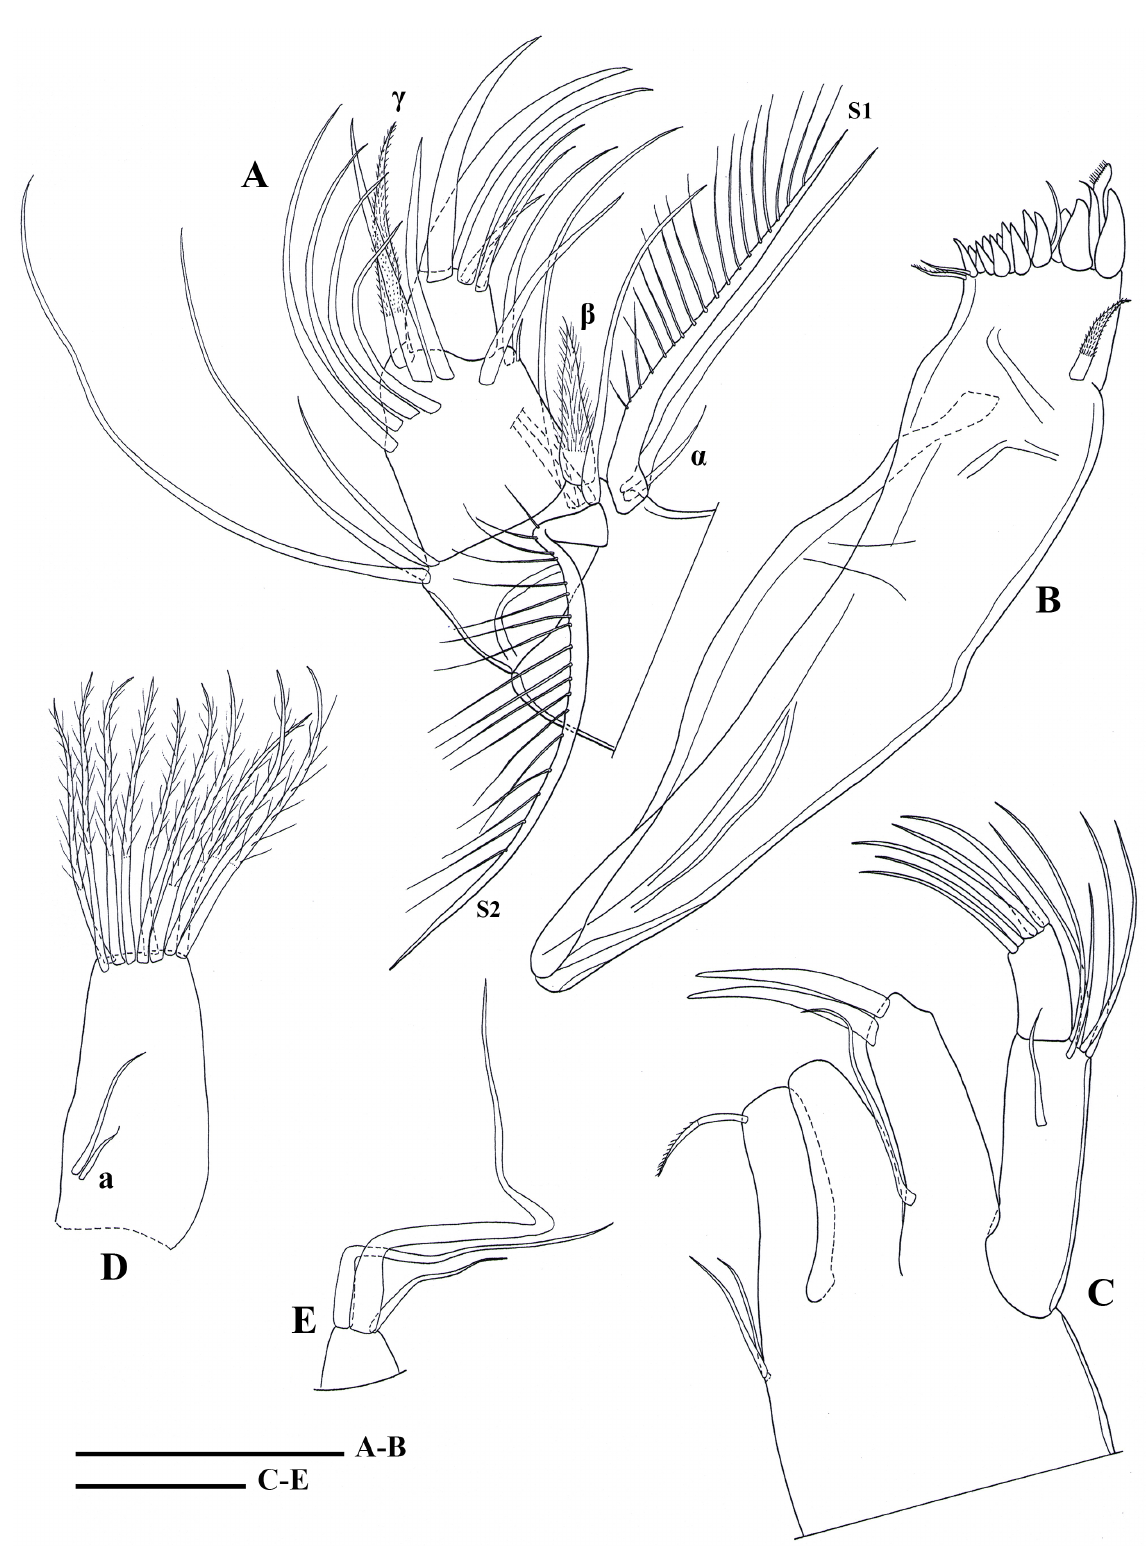
Fig. 4. Cyprettadopsis sutura gen. et sp. nov., ♀. A–D . MSU-ZOC.267. A . Md palp. B . Md coxa. C . Mx1, one sideways directed bristle on the first endite is drawn. D . T1. E . Terminal part of T1 endopodite (MSU-ZOC.268). Scale bars: A = 35 μm; B = 50 μm; C–E = 25